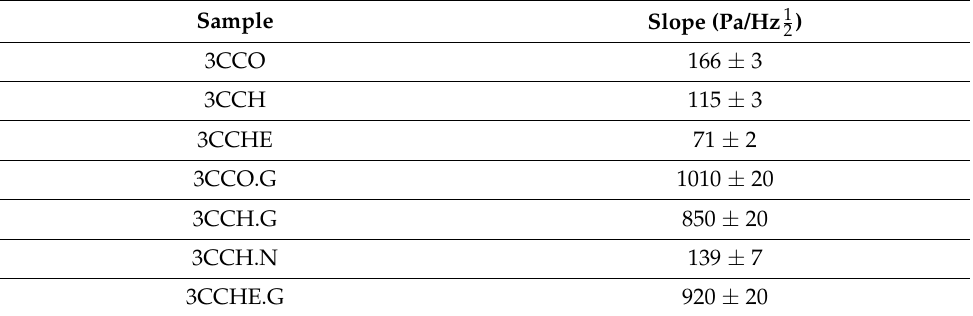
Table 3. Slope values of the linear region of Figures S9 and S10 obtained by linear regression of the experimental